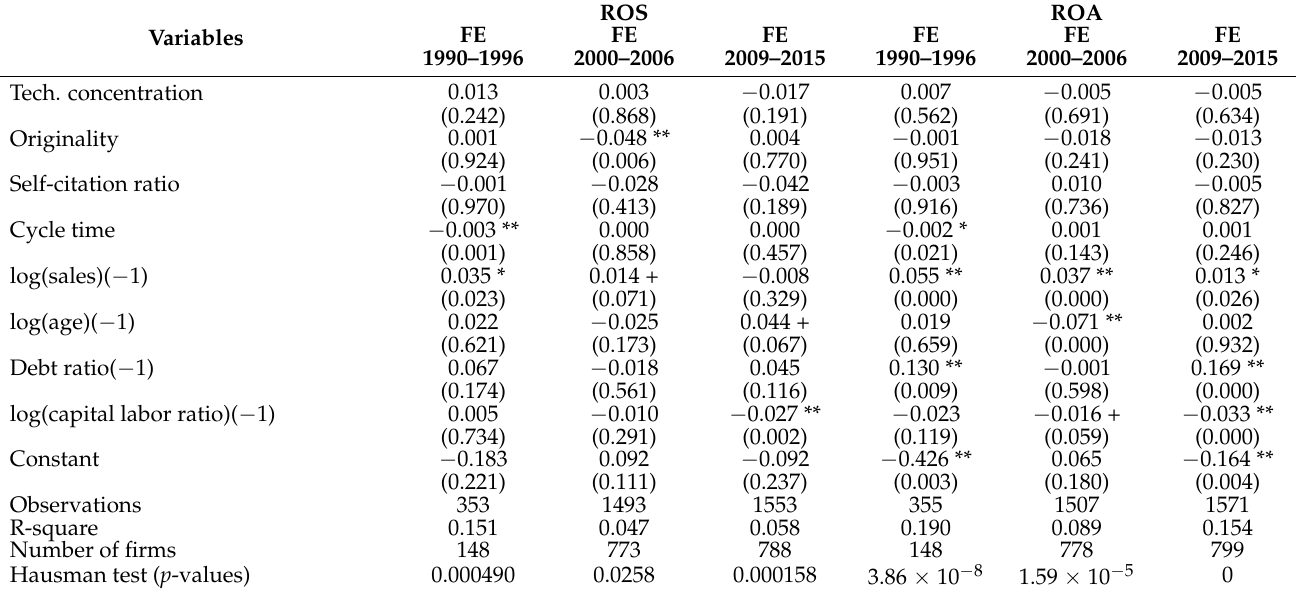
Table 9. Regression results of profitability on innovation variables.